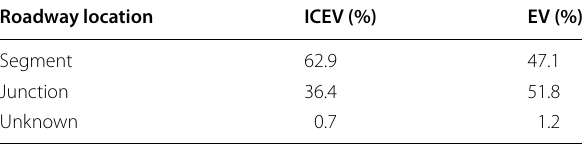
Table 4 Distributions of crashes by roadway location